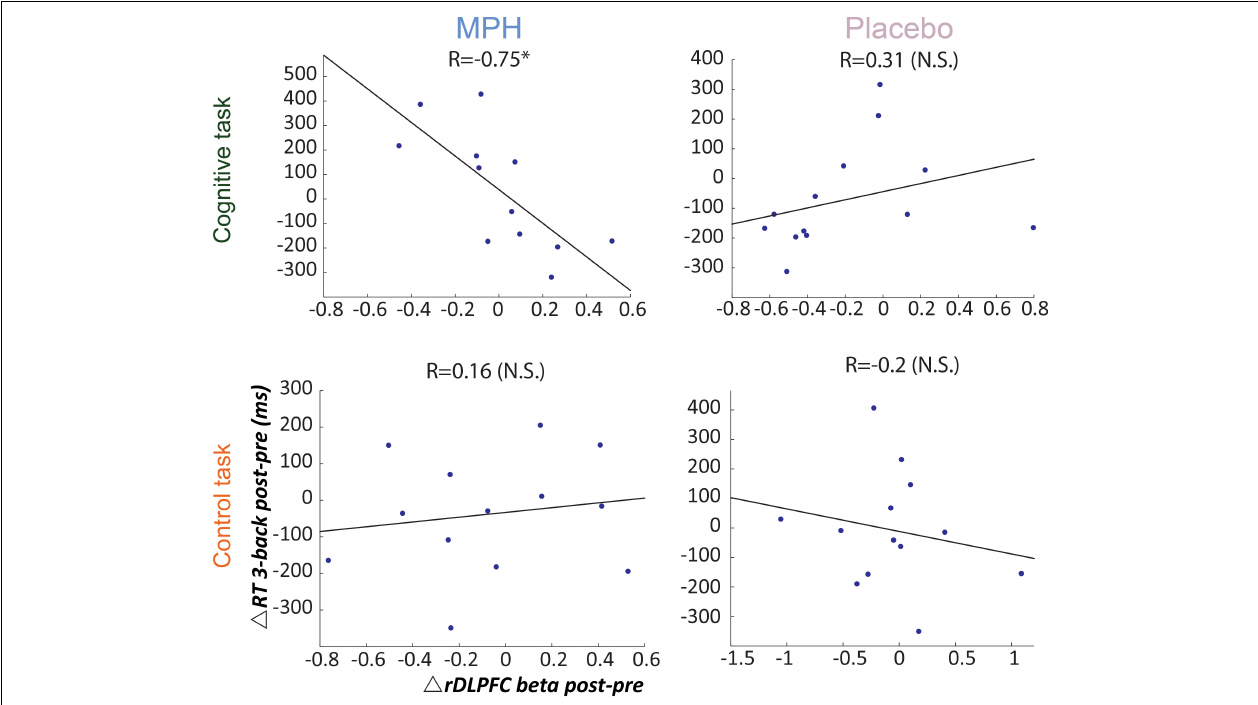
FIGURE 4 | Brain-behavior correlations for the 3-back load, with respect to drug administration and coupling condition. Relationship between change in RT (post vs. pre) and rDLPFC activity (post vs. pre) during the 3-back, following each coupling intervention (MPH-Cognitive, Placebo-Cognitive, MPH-Control, and Placebo-Control). Only the MPH during cognitive task revealed a significant correlation ( r = –0.75, P < 0.01). * p < 0.05 and ** p <